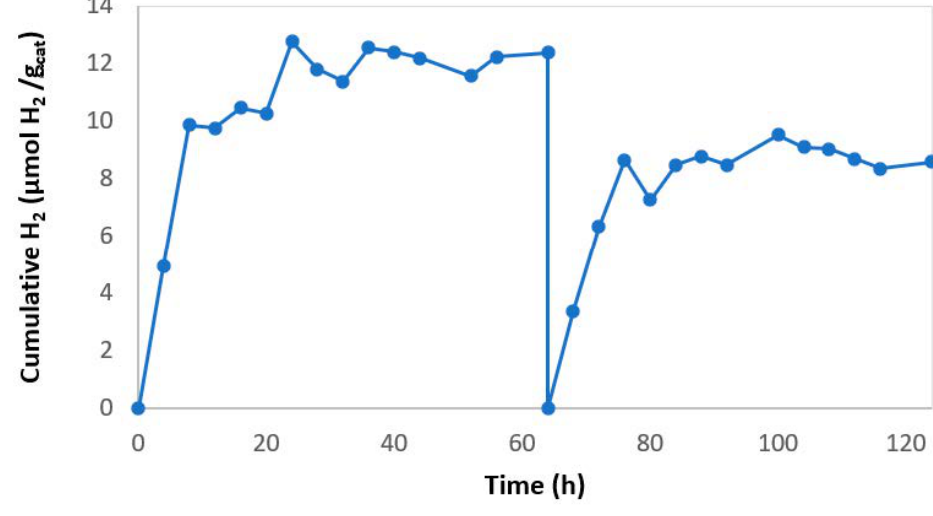
Figure 7. Hydrogen production with reused 2% rGO/TiO 2 SP membrane.